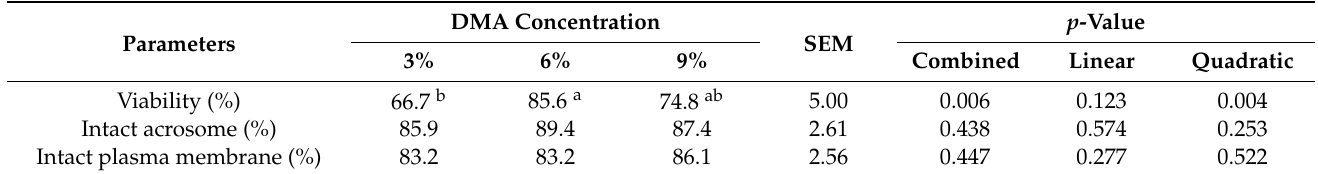
Table 3. Effect of dimethyl acetamide (DMA) concentration in semen freezing extender on the quality characteristics of rooster sperm after